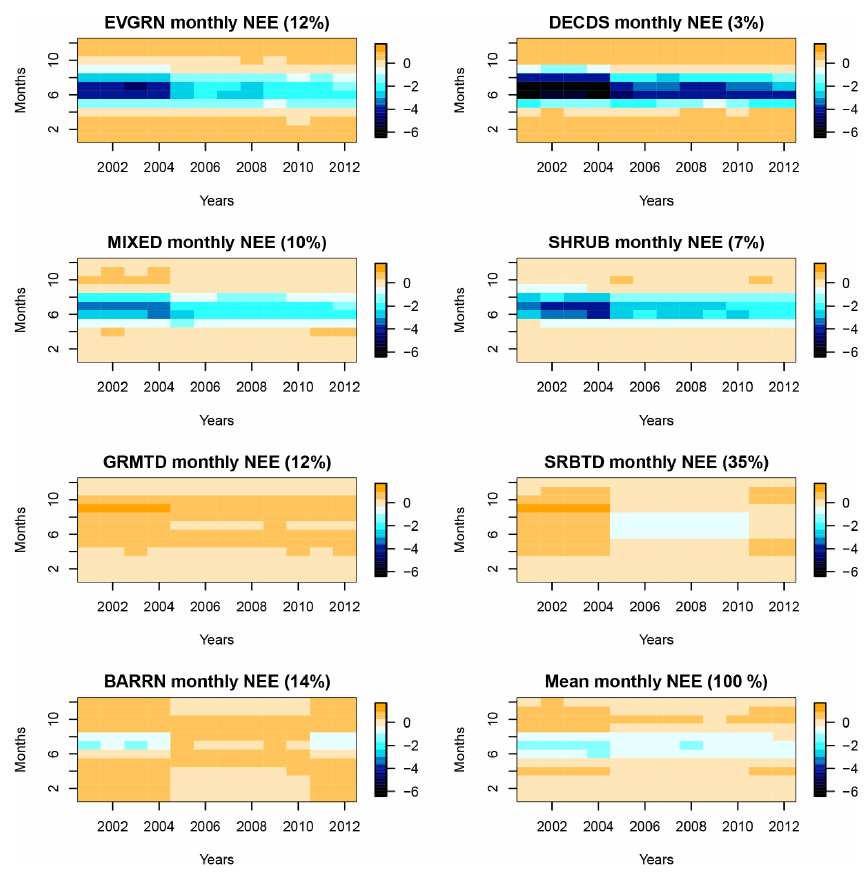
Figure 6. Average monthly NEE (in µmol CO 2 m − 2 s − 1 ) for the entire North American region north of 55 ◦ N (Mean), as well as for seven vegetation classes within this region: deciduous forest (DECDS), evergreen forest (EVGRN), mixed forest (MIXED), shrub (SHRUB), graminoid tundra (GRMTD), shrub tundra (SRBTD) and barren/wetland (BARRN). The percentage of the model domain covered by each vegetation class is indicated in the title of each